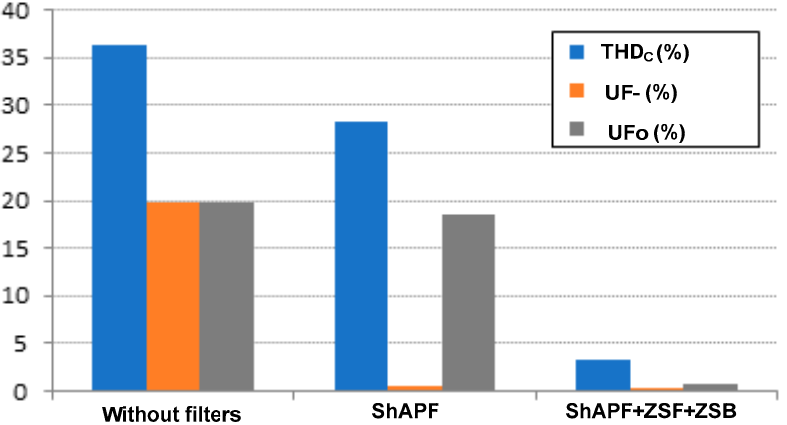
Figure 20. Total harmonic distortions and current unbalance factor with the variation of the filter arrangement with balanced load.